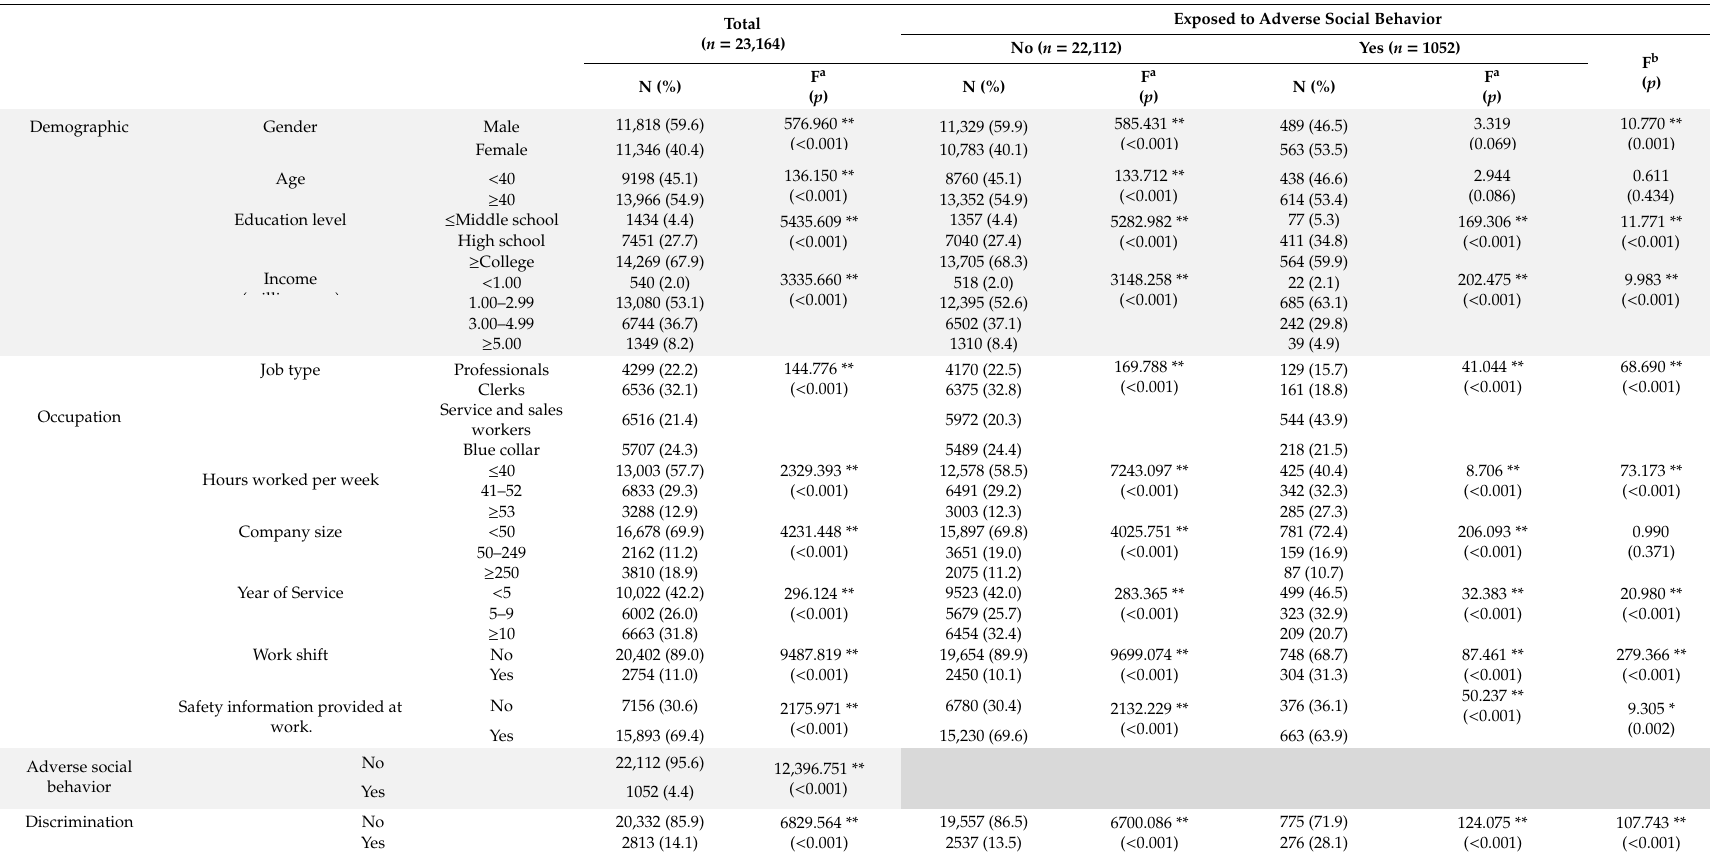
Table 1. Characteristics and presenteeism among the